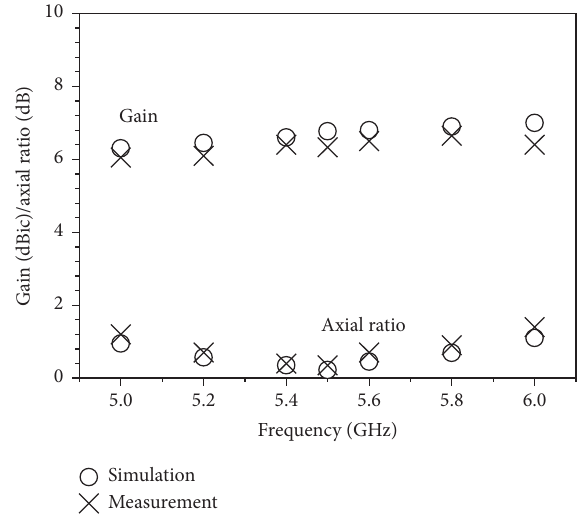
Figure 9: Gain and axial ratio of the fabricated feed versus the